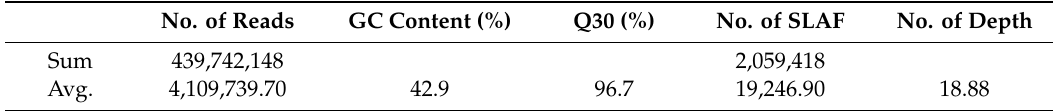
Table 2. Summary of specific locus amplified fragment sequencing